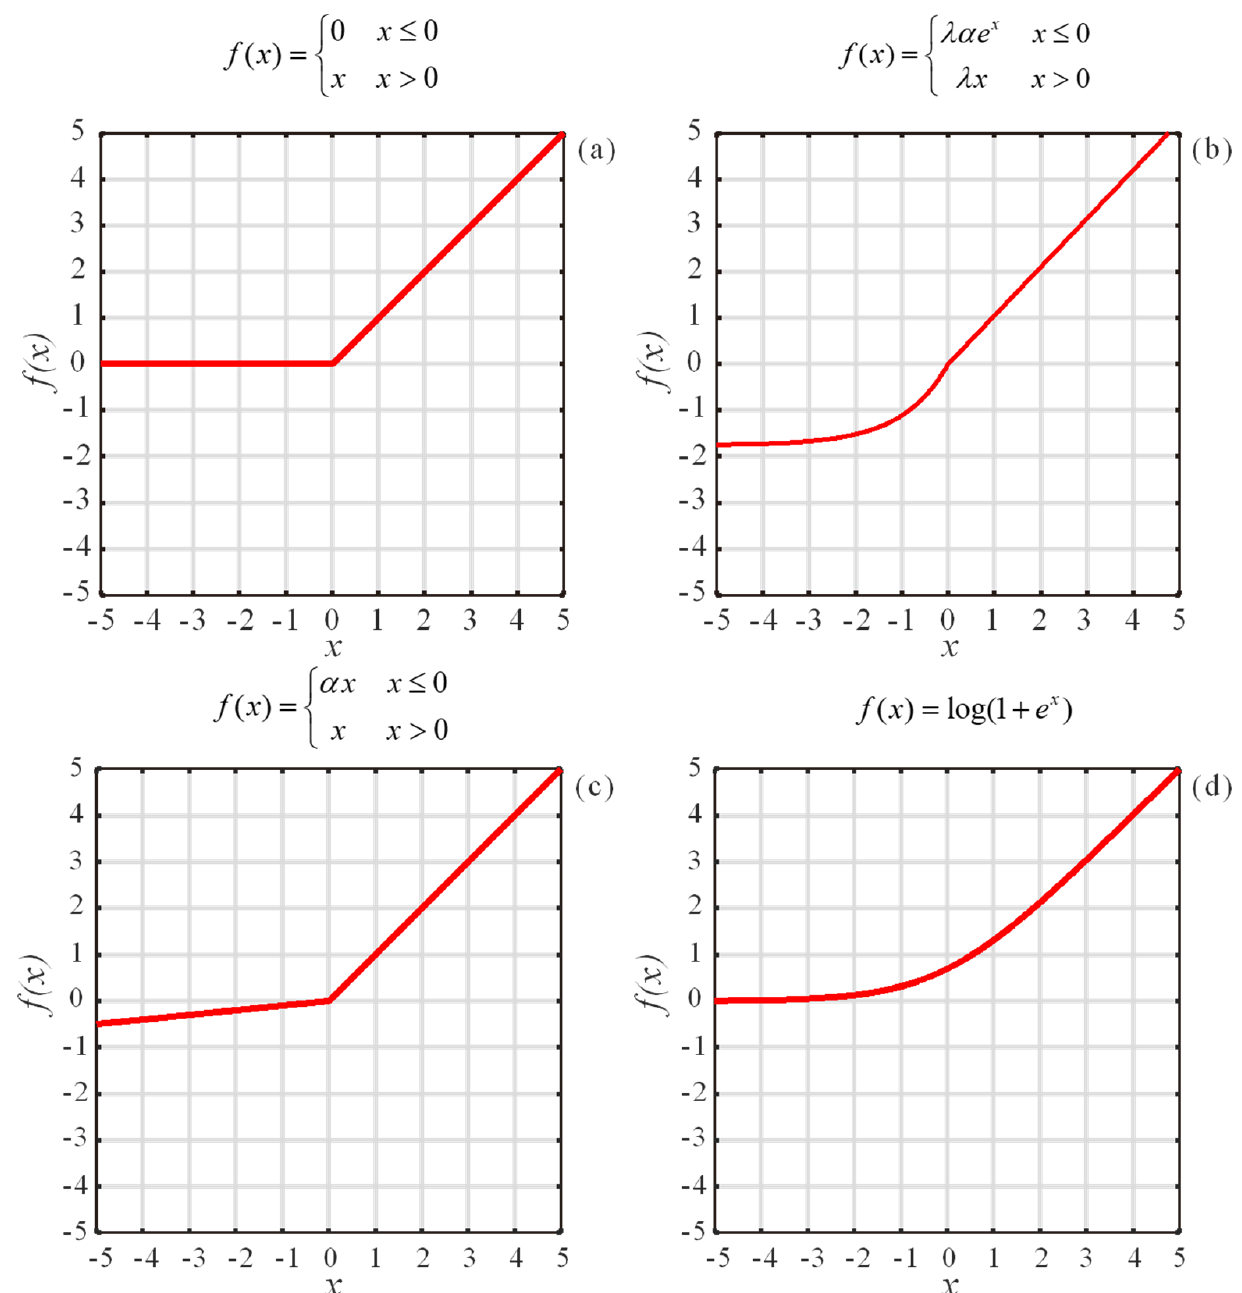
Figure 4. Geometric images of the four activation functions. ( a ) Relu function; ( b ) Selu function; ( c ) Leaky_Relu function; ( d ) Softplus function. Where λ is 1.05070098, and α is 1.67326324 and 0.1 in ( b ) and ( c ), respectively.